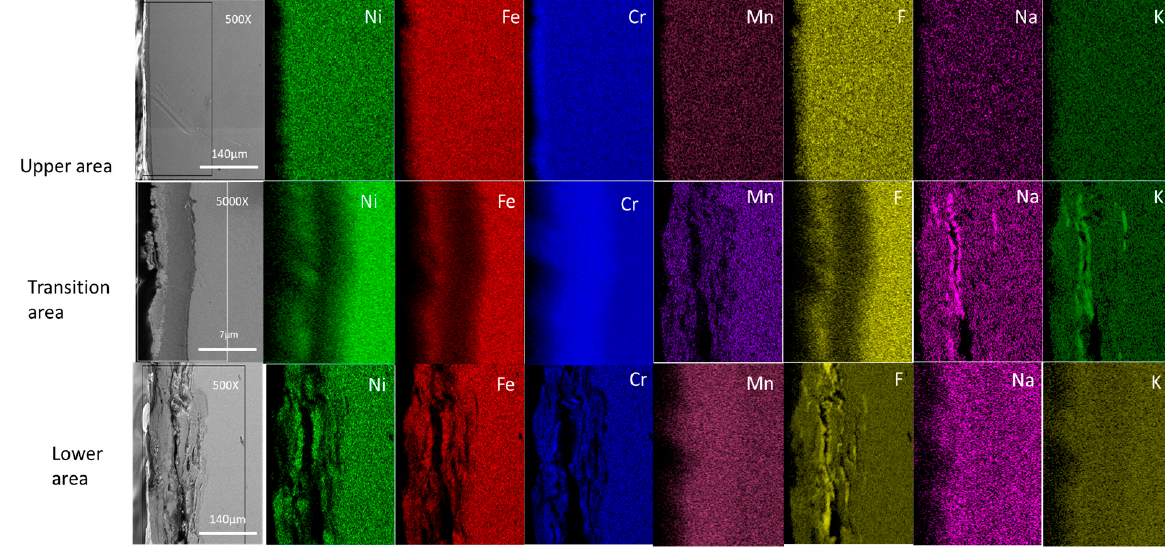
Figure 8. Cross section of Incoloy ® 800H.